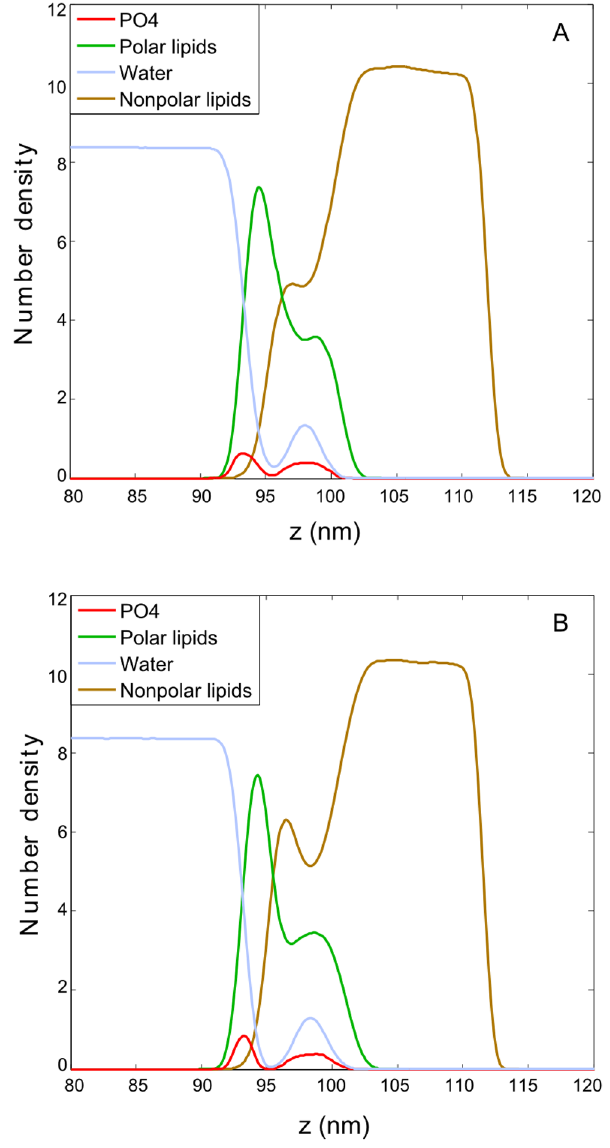
Figure 9. Density profiles calculated during the non-equilibri- um lateral compression. The profiles are taken in the initial (40- 100 ns) (A) and final (100-150 ns) (B) phase of the non-equilibrium lateral squeezing.